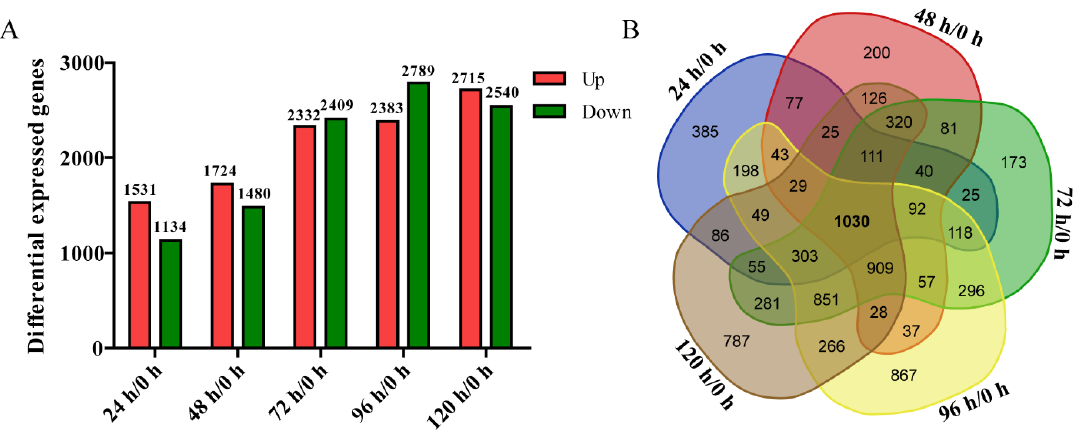
Figure 1. Summary of differentially expressed genes (DEGs) in W. anomalus YF1503 and Venn dia- gram of DGEs under different fermentation times. ( A ) The number of up-regulated (Up) or down- regulated (Down) genes under different fermentation times. ( B ) Venn diagrams showing the total number of significantly DEGs ( p -value ≤ 0.05) at 24 h, 48 h, 72 h, 96 h, and 120 h compared with 0 h.